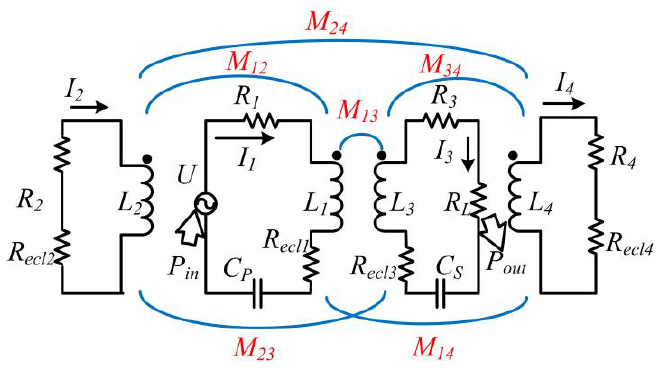
Figure 3. The equivalent circuit model of the underwater WPT system with two shielding coils.